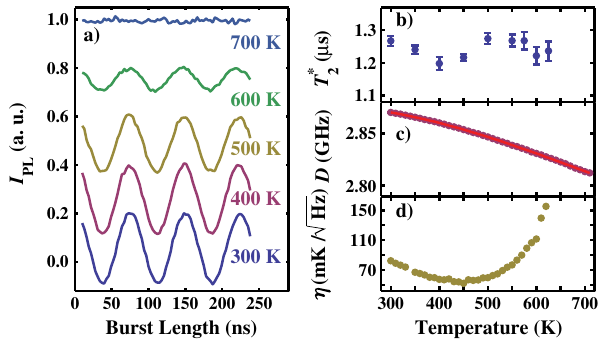
FIG. 5. (a) Rabi oscillations on the m s ¼ 0 to m s ¼ (cid:5) 1 tran- sition at varying temperatures. The measurements are offset for clarity. (b) T (cid:1) 2 versus temperature inferred from the decay envelope of fits to Ramsey oscillations. These measurements were performed at approximately 500 G to polarize the NV center’s 14 N nuclear spin to simplify its hyperfine spectrum. All other measurements were performed at approximately 45 G. Error bars represent 68% intervals. (c) The crystal field splitting, D ð T Þ , inferred from Lorentzian fits to the CW ESR data. The solid red line is the third-order polynomial fit to the data given in the main text. (d) Single-spin thermal sensitivity ( (cid:3) ). (cid:3) was calculated using Eq. (2) with all parameters from the same NV